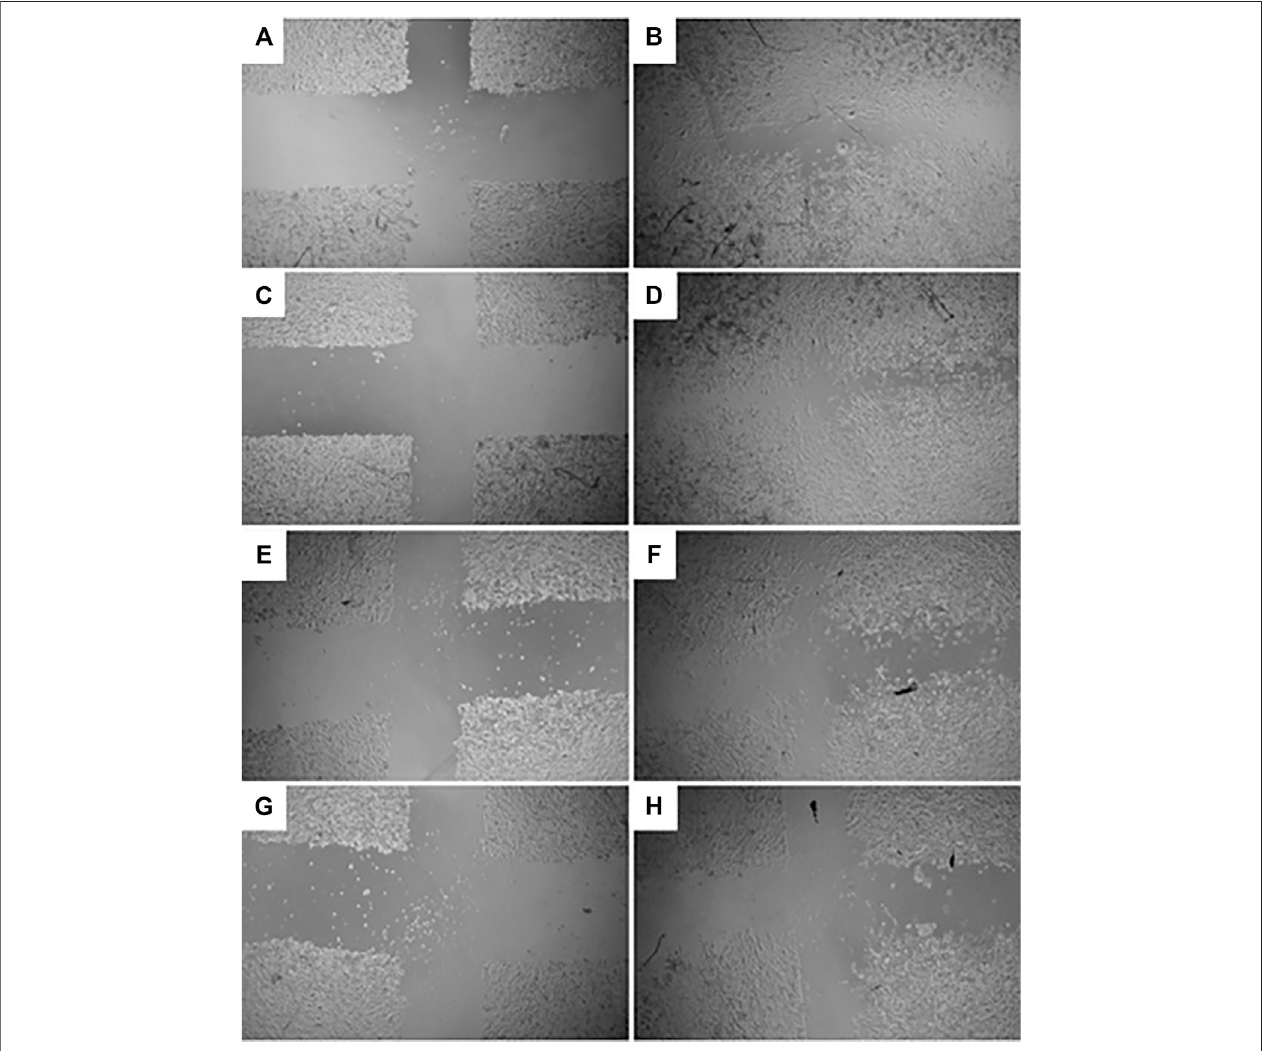
FIGURE4| Images (×4 magni fi cation) representing woundclosure at 0and 18 hincubation time of (A) untreated media control at0 hand (B) after 18 h(C)0.25% DMSO vehicle control after 0 h and (D) after 18 h (E) G. radlkoferi EtOH leaf extract (50 μ g/ml) after 0 h and (F) after 18 h incubation (G) G. radlkoferi EtOH leaf extract (100 μ g/ml) after 0 h and (H) after 18 h